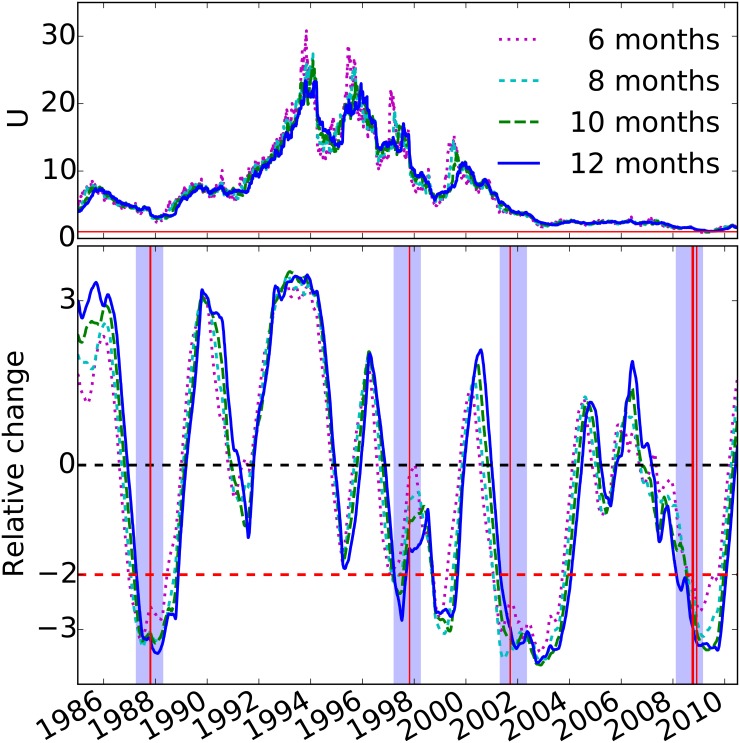
Model parameter U (top panel) and relative change in model parameter (bottom panel) for the period 1985–2010, and for varying values of the sliding time window.Similar to that of Fig 3, but for sliding time windows of 6, 8, 10, and 12 months. The relative change of U is based on the window-long period for which U was estimated. For all cases, four year-long intervals that follow two standard deviation drops in the model parameter overlap with the largest percentage drop events displayed by the vertical red lines.